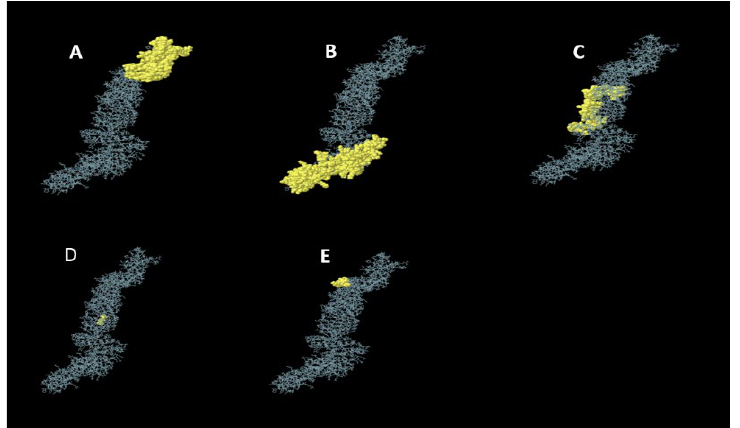
Figure 3. The 3D structure of the 5 predicted conformational (discontinuous) B-cell epitopes in the refined MEV construct. The yellow parts are the conformational B-cell epitopes, while the gray parts are the rest of the residues. ( A ) A total of 161 residues with a score of 0.774. ( B ) A total of 183 residues with score of 0.696. ( C ) A total of 76 residues with a score of 0.630. ( D ) A total of 3 residues with a score of 0.547. ( E ) A total of 7 residues with a score of 0.543.